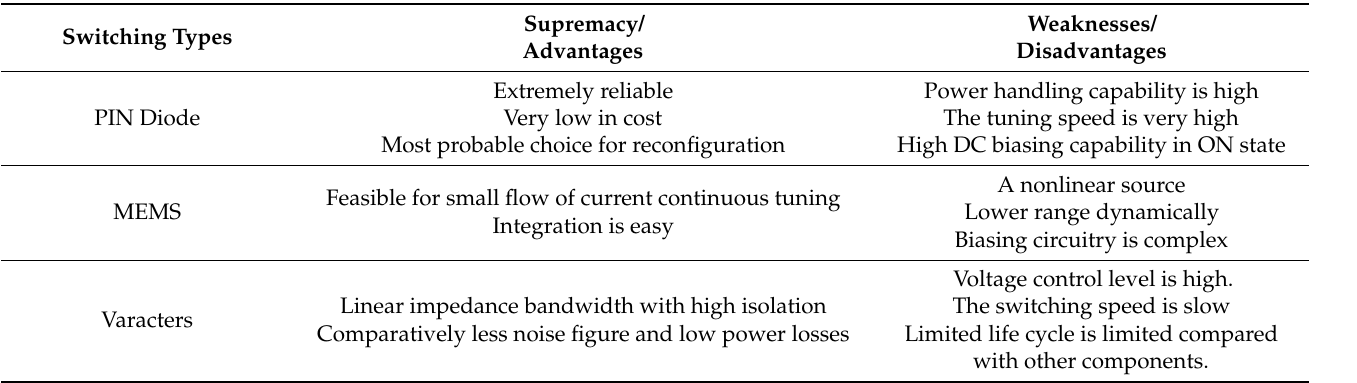
Table 4. A comparison of different switch components